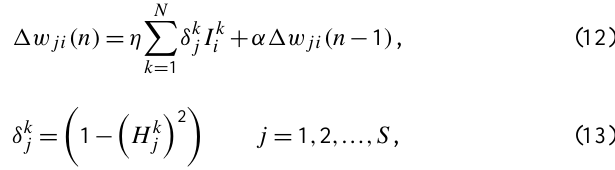
Fig. 3. Architecture of Elman neural network